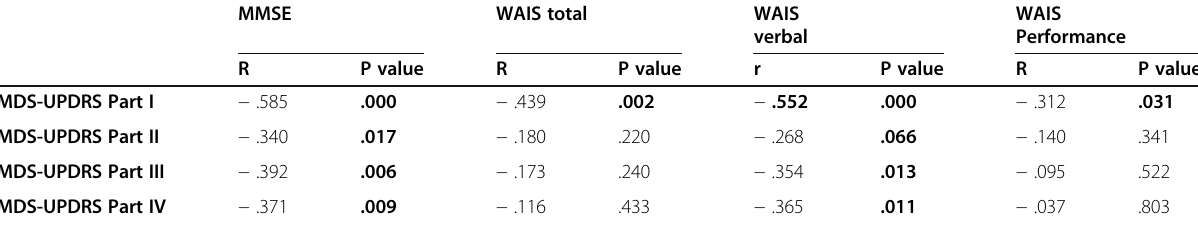
Table 4 Correlation between MDS-UPDRS* and MMSE** and WAIS-R***